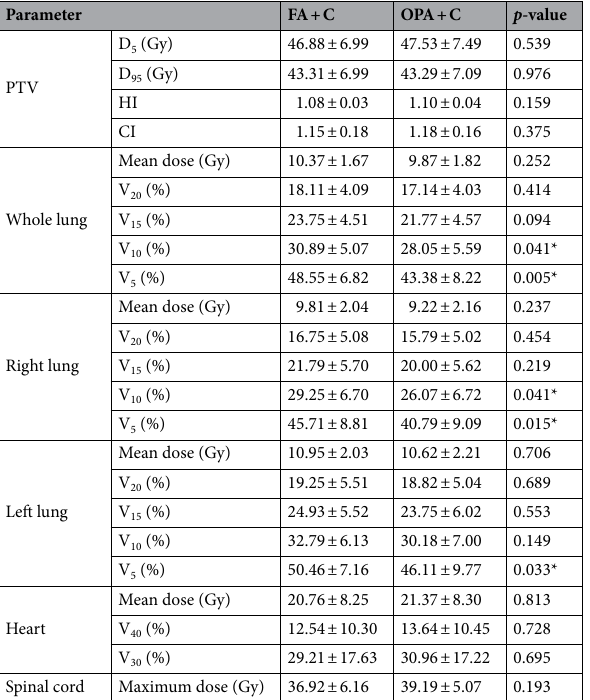
Table 2. Comparison of dosimetric factors between FA + C and OPA + C plans. FA + C full arcs plans with constraints, OPA + C optimal partial arcs plans with constraints, PTV planning target volume, CI conformity index, HI heterogeneity index. *Represents significant difference (p < 0.05).